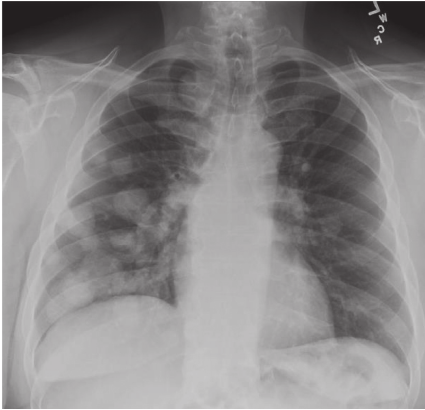
Figure 1: Initial chest X-ray showing multiple new pulmonary